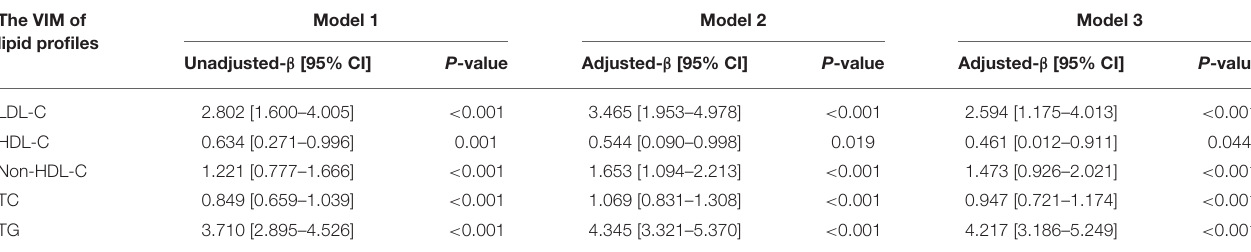
TABLE 4 | Linear regression analyses of average follow-up HbA1c levels on the visit-to-visit variability of lipid profiles. The VIM of lipid